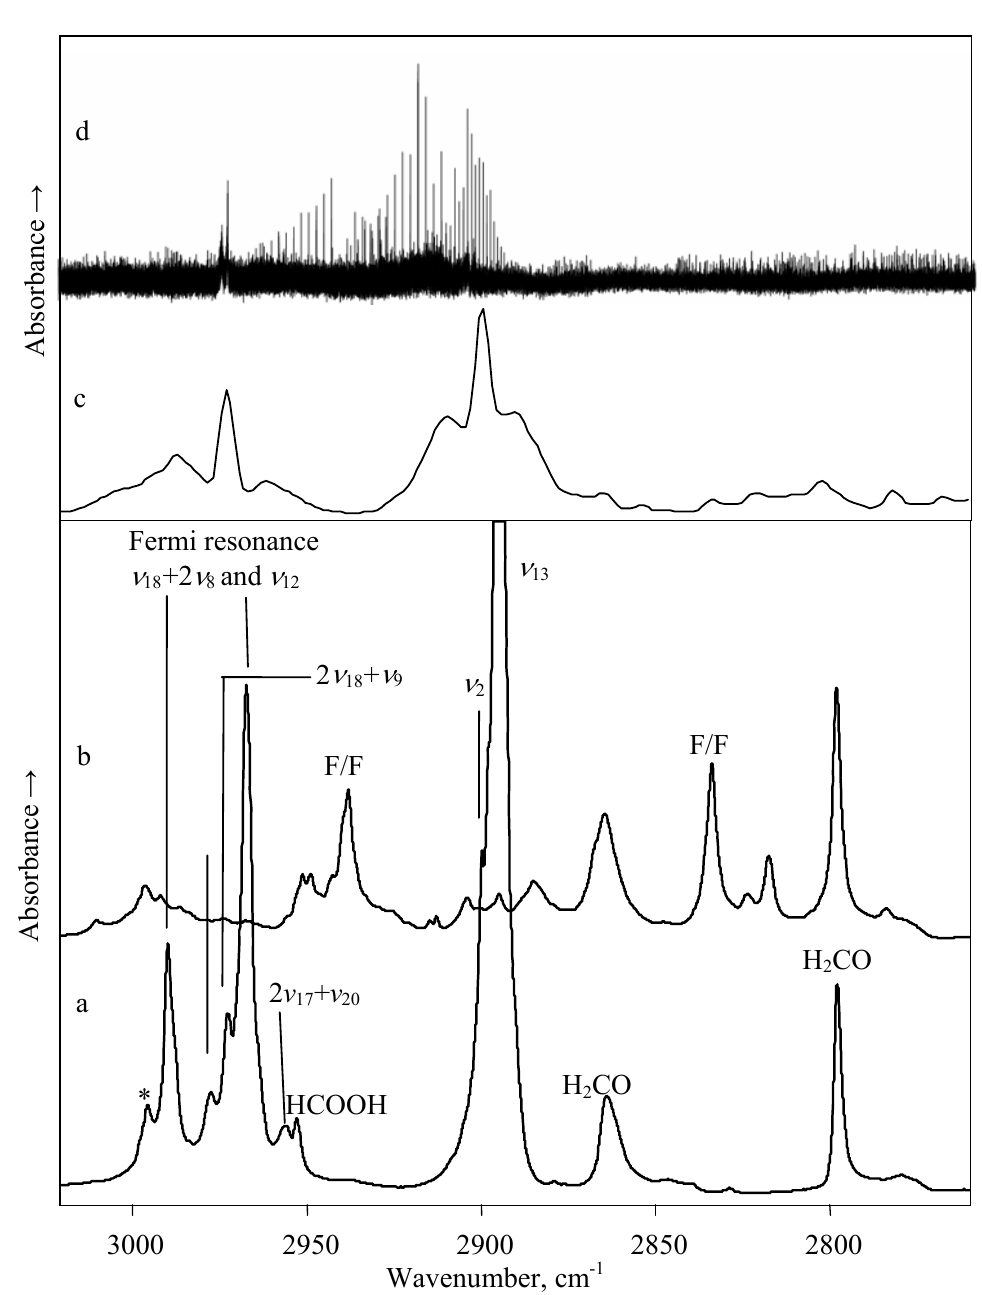
Fig. 6 IR absoption spectra of (a) ethene SOZ isolated in Ar matrix; (b) the sample after photolysis with UV radiation; (c) gaseous ethene SOZ (resolution 4 cm − 1 ); (d) gaseous ethene SOZ (resolution 0.003 cm − 1 ) in the wavenumber range of the CH stretch vibrations. F/F- formic acid-formaldehyde dimer [5], * - not identified product. The selected spectral region of the overtones and combination vibrations in the spectrum of the matrix isolated ethene SOZ before and after photolysis is presented in Fig. 7. The spectral bands disappearing after photolysis were assigned to the ethene SOZ overtones and combination bands. In such a way more than 30 new combination and